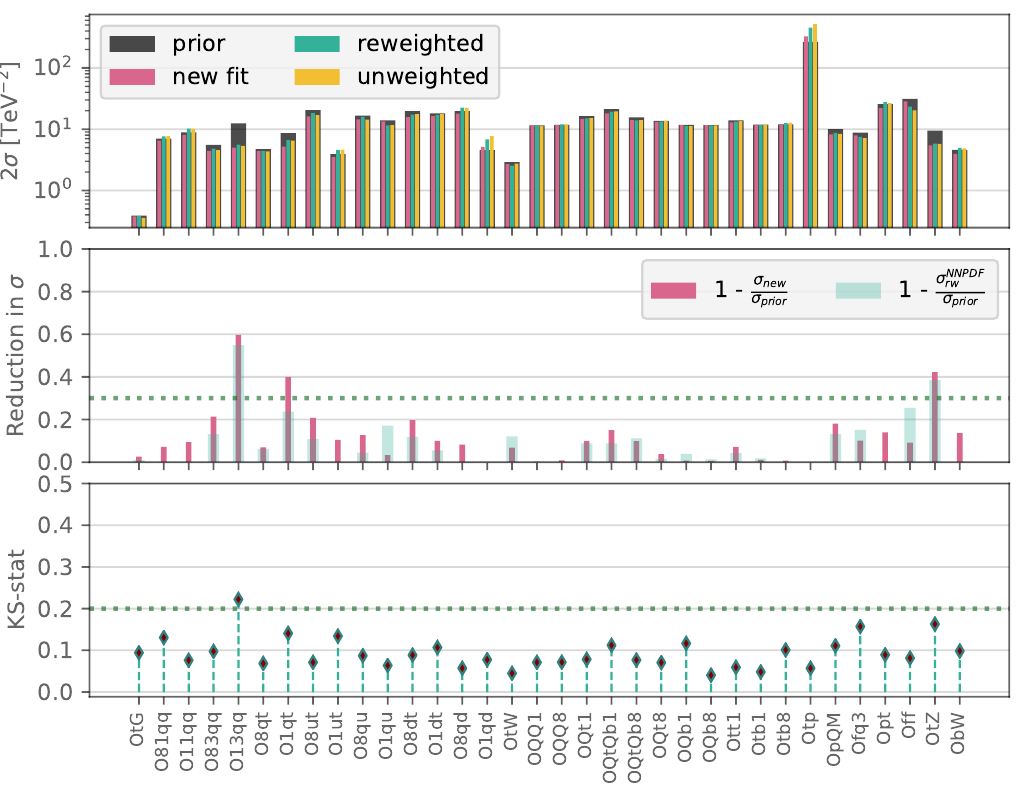
Figure 3.5: Same as Fig. 3.3, but in the case of single-top s -channel production total